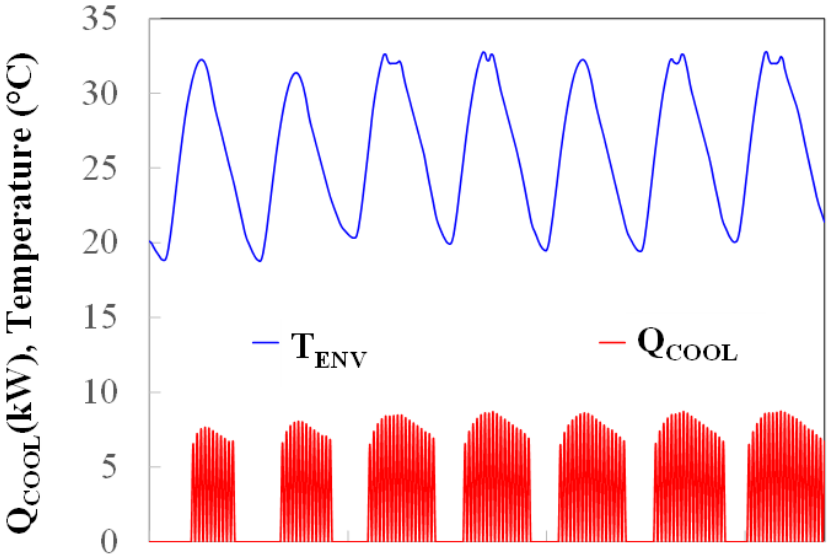
Figure 7. Environmental temperature behavior over one week. Table 2. Building characteristics.